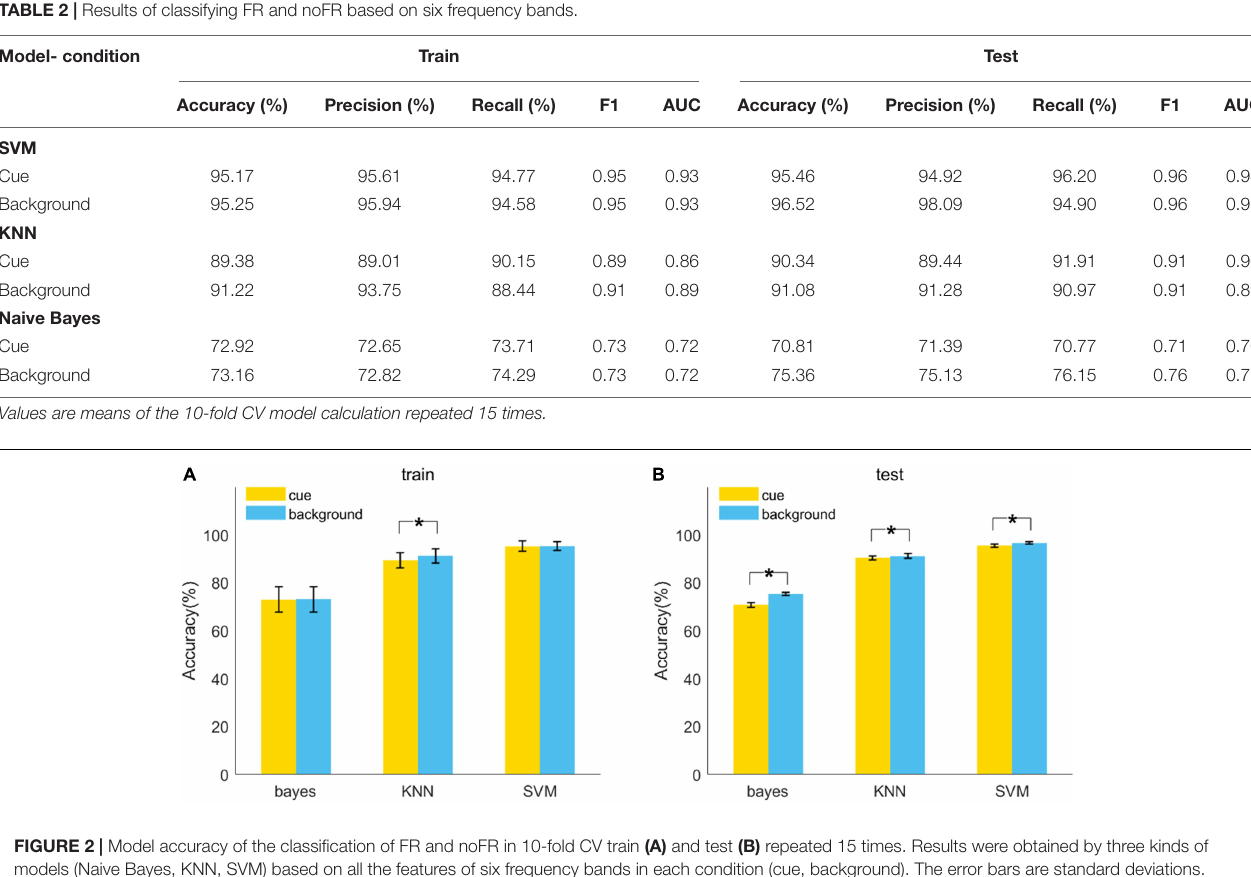
background: 28 EFs in alpha, 28 EFs in gamma,